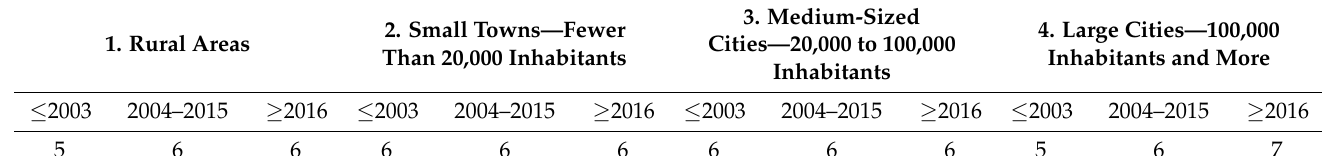
Table 1. The number of analyzed plans in particular groups.